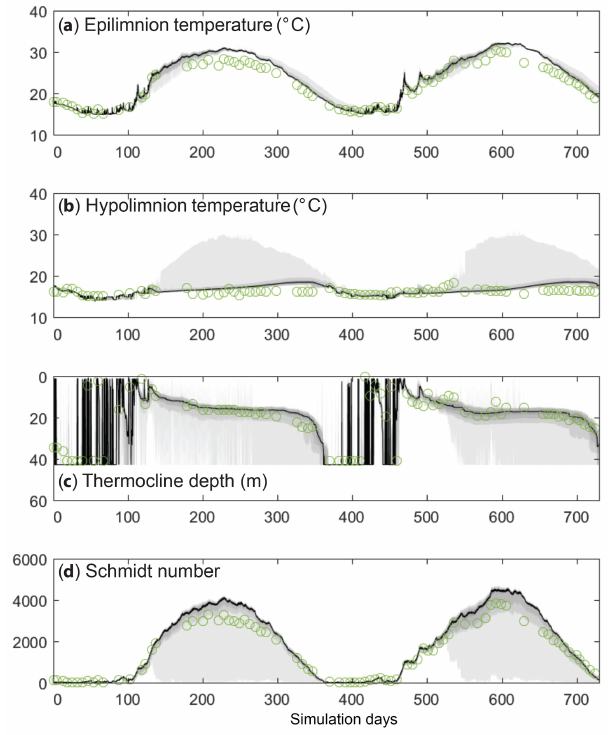
Figure 19. Depiction of parameter uncertainty for a GLM simu- lation of Lake Kinneret, Israel, following calibration against ob- servations (green circles) via MCMC for (a) epilimnion temper- ature, (b) hypolimnion temperature, (c) thermocline depth, and (d) Schmidt number. The black line indicates the 50th percentile likelihood of the prediction, and the grey bands depict the 40th, 60th, and 80th